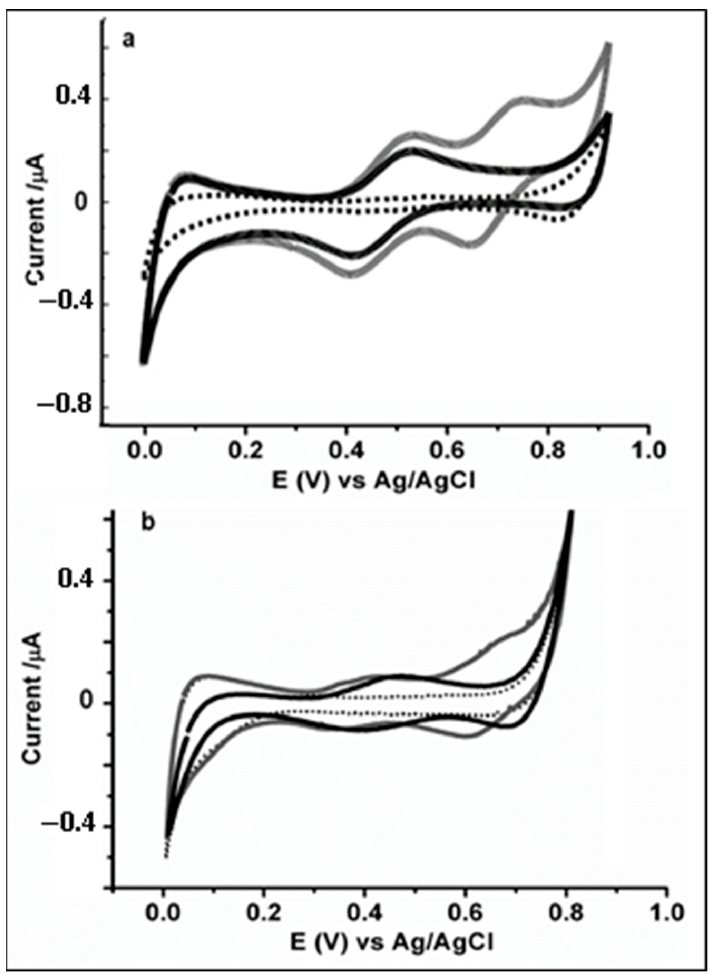
Figure 6. Cyclic voltammetry at artificial serum|1,6-DCH micro-ITIES array at 10 mV/s(Cell 2). An artificial serum solution (no analyte) (dotted line), 24 µ M DIC + (black line) and 40 µ M TMA + (grey line) for artificial serum without BSA ( a ) and artificial serum with BSA ( b